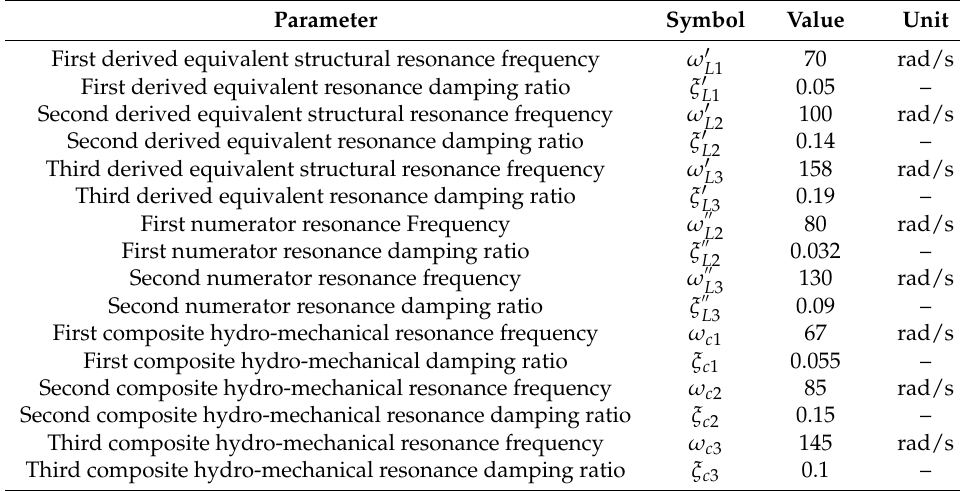
Table 4. The identified parameters of the sixth-order load model. Parameter Symbol First derived equivalent structural resonance